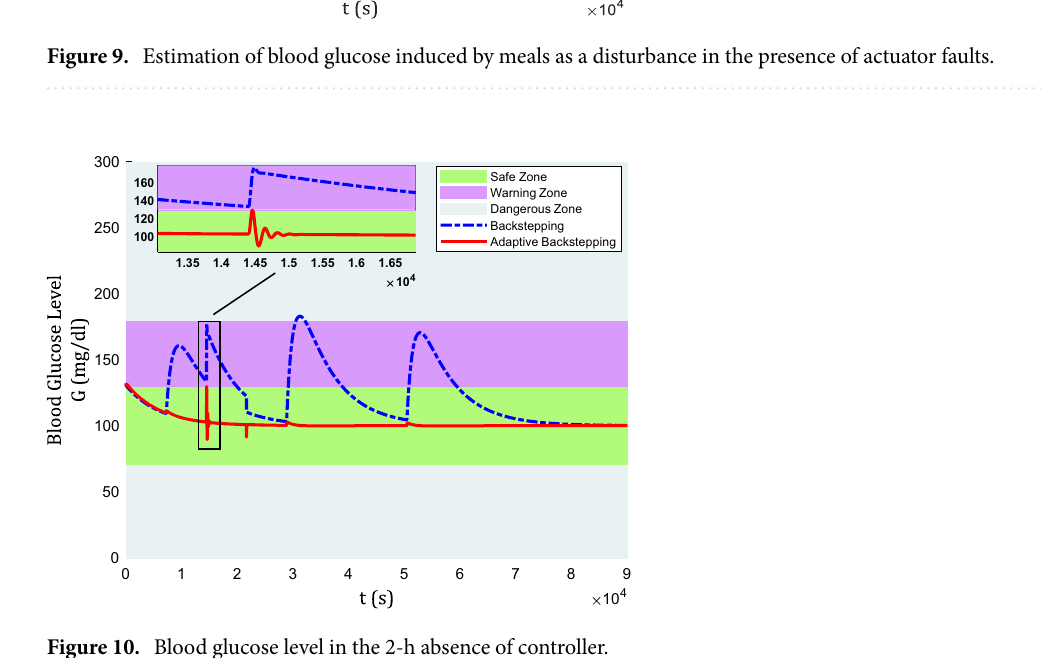
Figure 10. Blood glucose level in the 2-h absence of